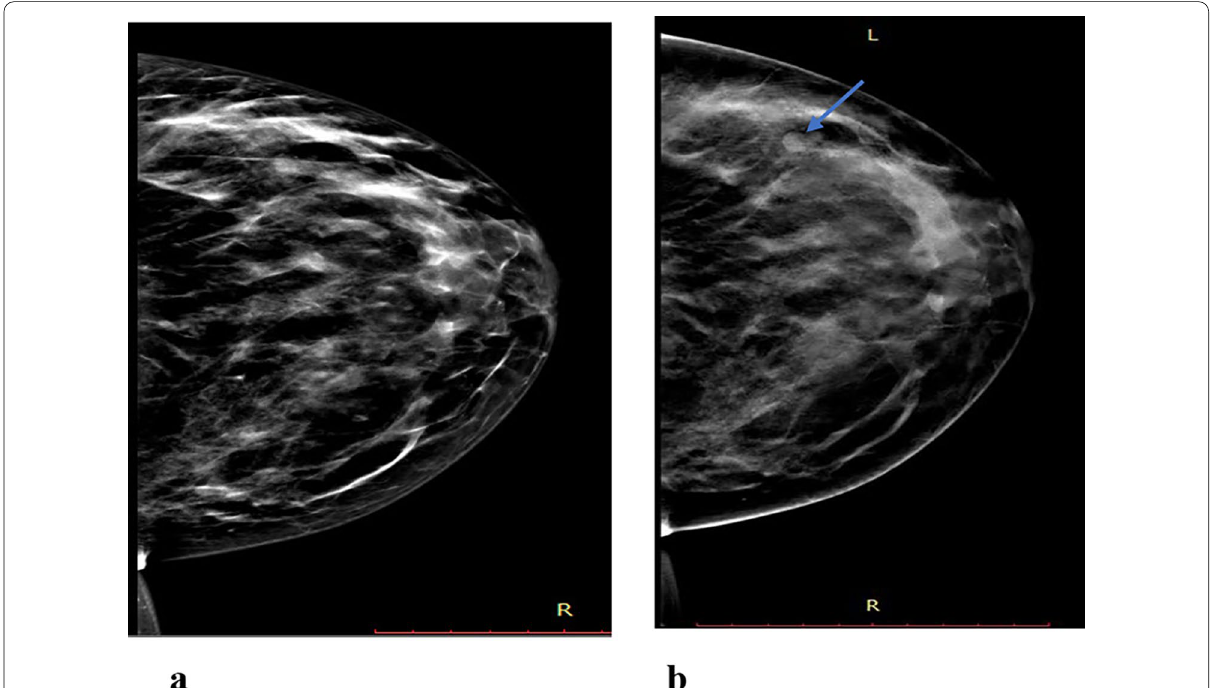
Fig. 1 A 39-year-old female complained of mastalgia in left breast with positive family history (first degree relatives) for breast cancer. a CC view of 2DDM of left breast shows heterogeneously dense breast (ACR c) with no abnormality detected. b CC view of DBT of left breast shows well-defined bilobed isodense mass in outer quadrant (BIRADS 3), proved by histopathology to be